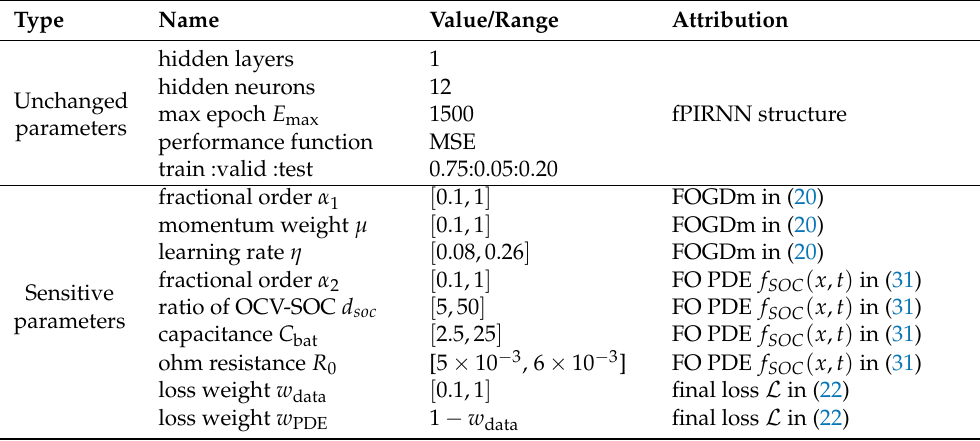
Table 3. Unchanged parameters and sensitive parameters of the proposed fPIRNN.